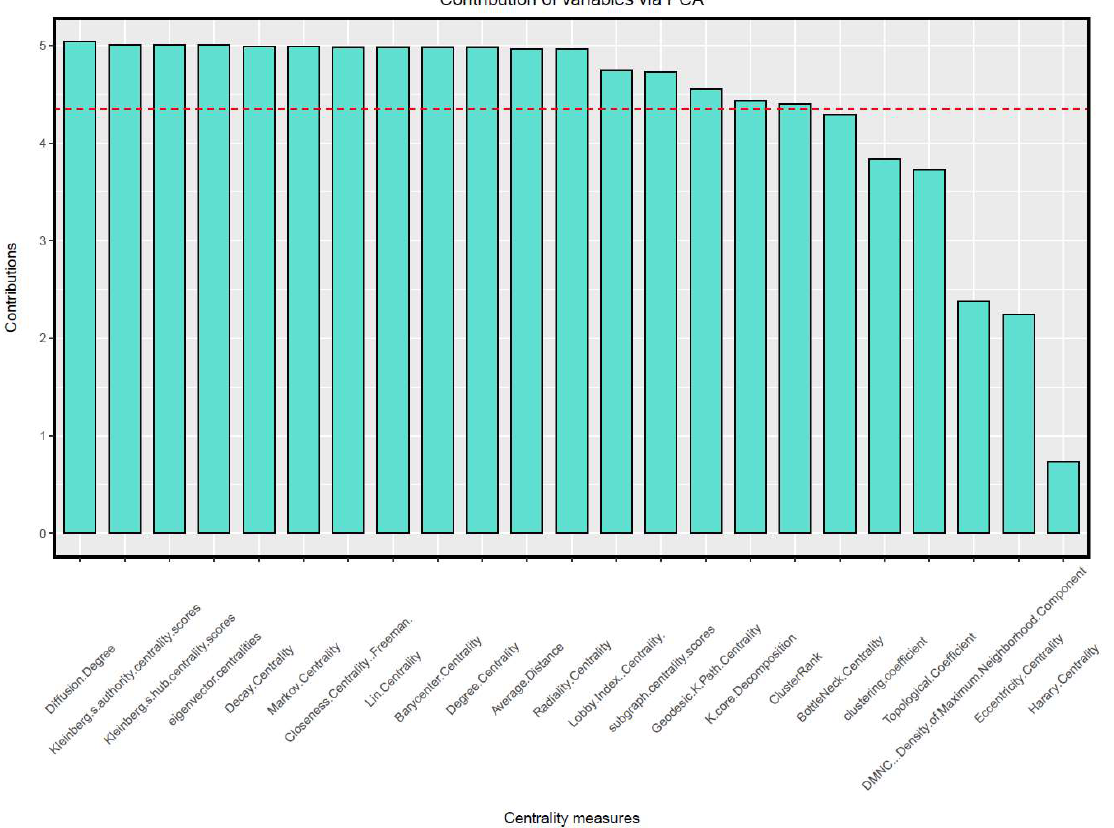
Figure A3. Principal component analysis (PCA) analysis of 23 key centrality measurements to determine the most informative centrality measurement for the PPI network.